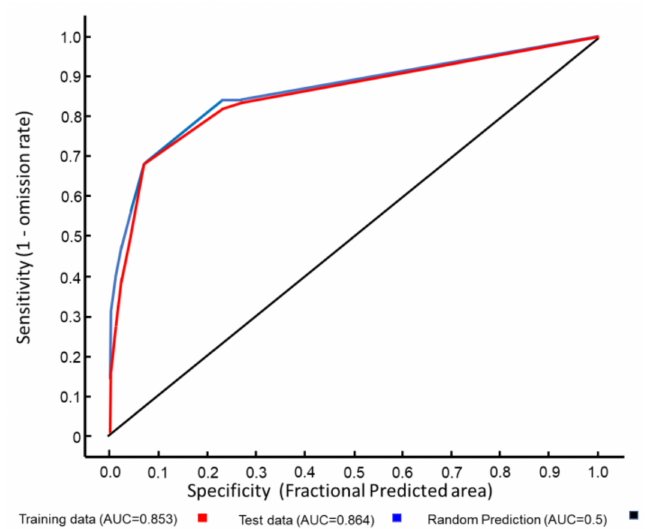
Figure 3. ROC curve for the MAXENT modelling of the potential distribution of Anoxia orientalis in